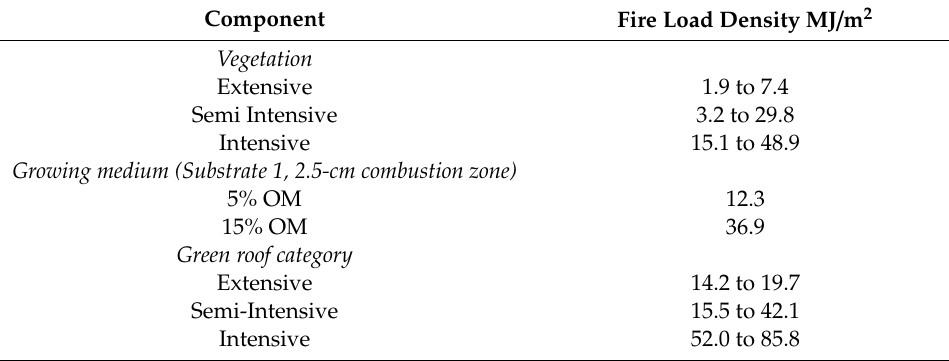
Table 4. Fire load density of green roof and its components.